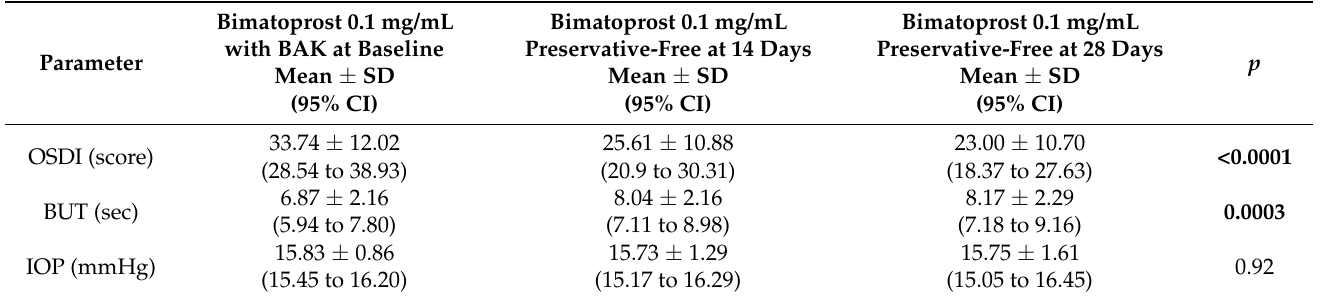
Table 1. Comparisons between Bimatoprost 0.1 mg/mL with BAK at baseline and Bimatoprost 0.1 mg/mL preservative-free at 14 and 28 days relative to ocular parameters.